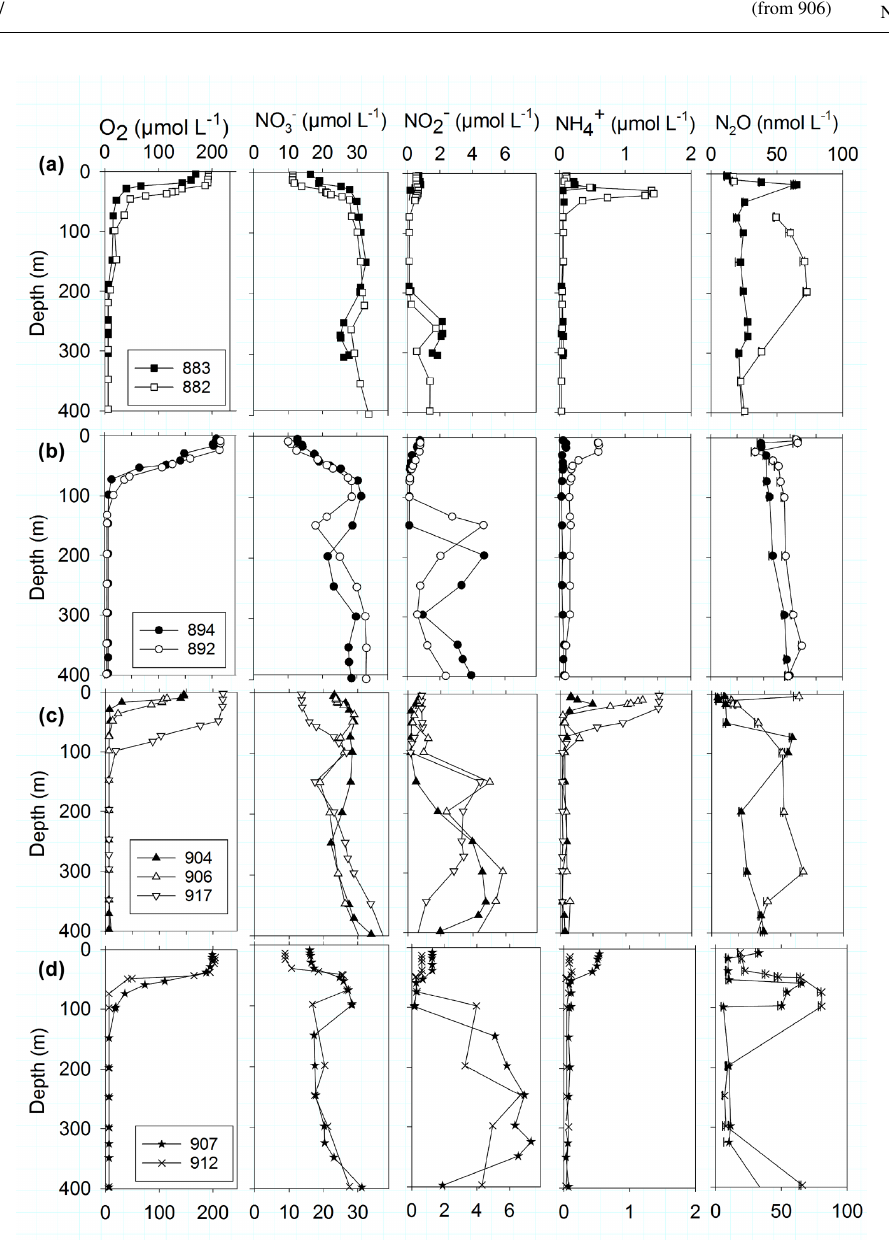
Figure 2. Depth profiles of O 2 , nutrients and N 2 O in the upper 400m for all stations. Panels (a) – (d) refer to the transect numbers